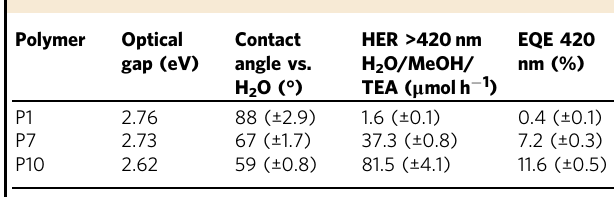
Table 1 Polymer characterization and hydrogen